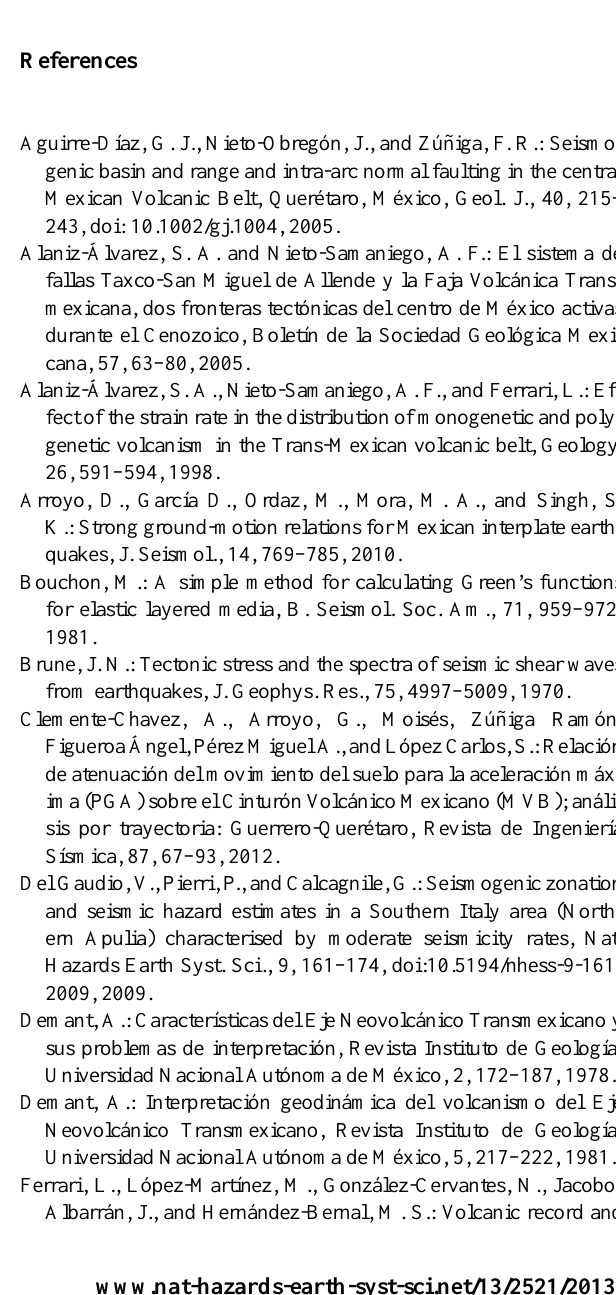
Fig. 9. Premonitory earthquakes for the event No. 2 of M w = 3.0 are shown. The figure shows that there are between 20 to 60s before of the main